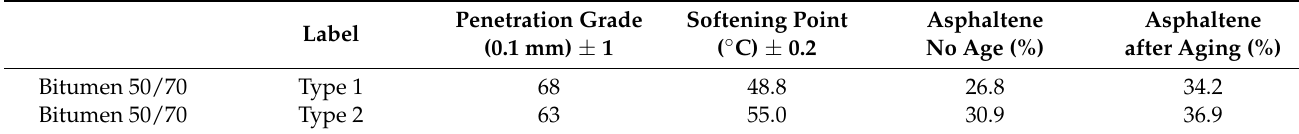
Table 1. Information about the bitumens.